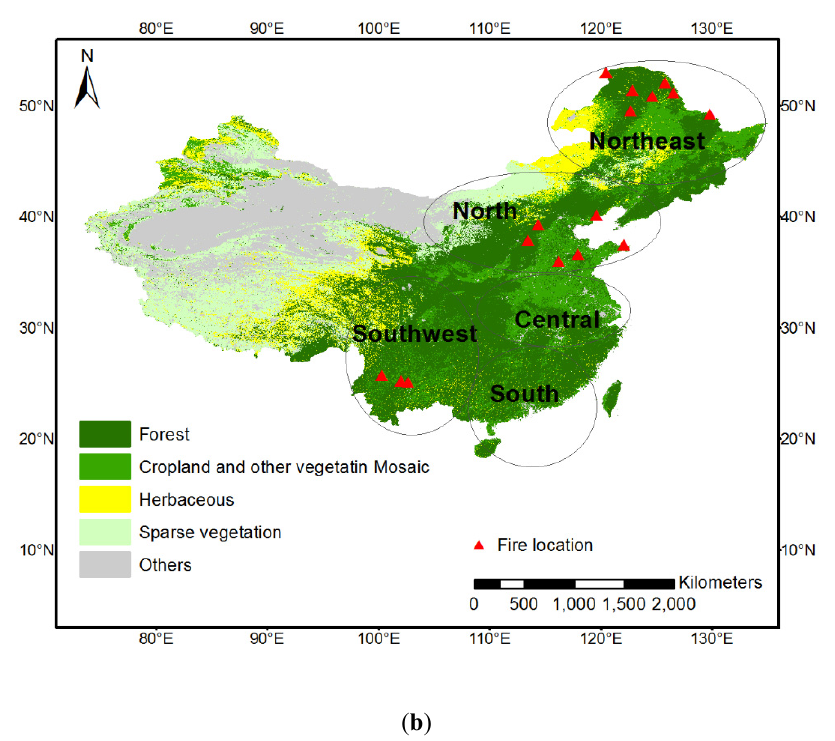
Figure 1. Elevation ( a ) and land cover ( b ) in China with geographic regions in eastern China and fire locations (The data used to produce this figure were from [33]).